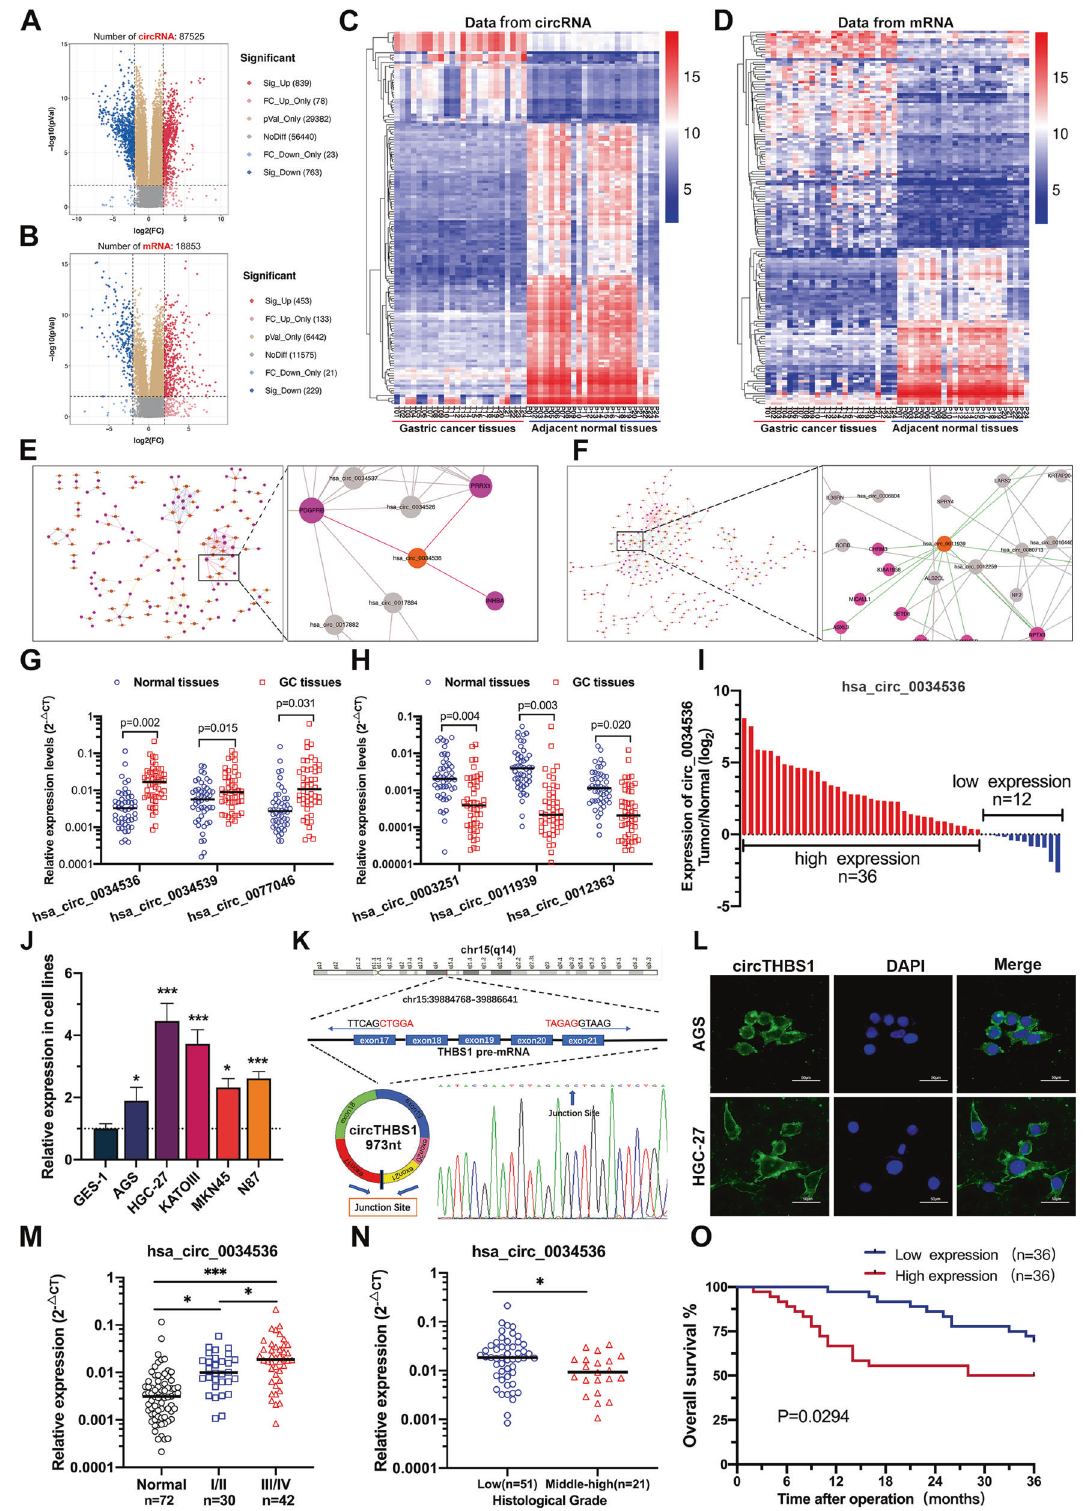
cancerous tissues (Fig. 1G, H). We found that the expression of hsa_circ_0034536 (termed circTHBS1) was upregulated in GC tissues with the most signi fi cant difference (Fig. 1I). Meanwhile, higher expression levels of circTHBS1 were detected in GC cell lines compared to the gastric mucosal epithelial cell lines (GES-1) Cell Death and Disease (2022)